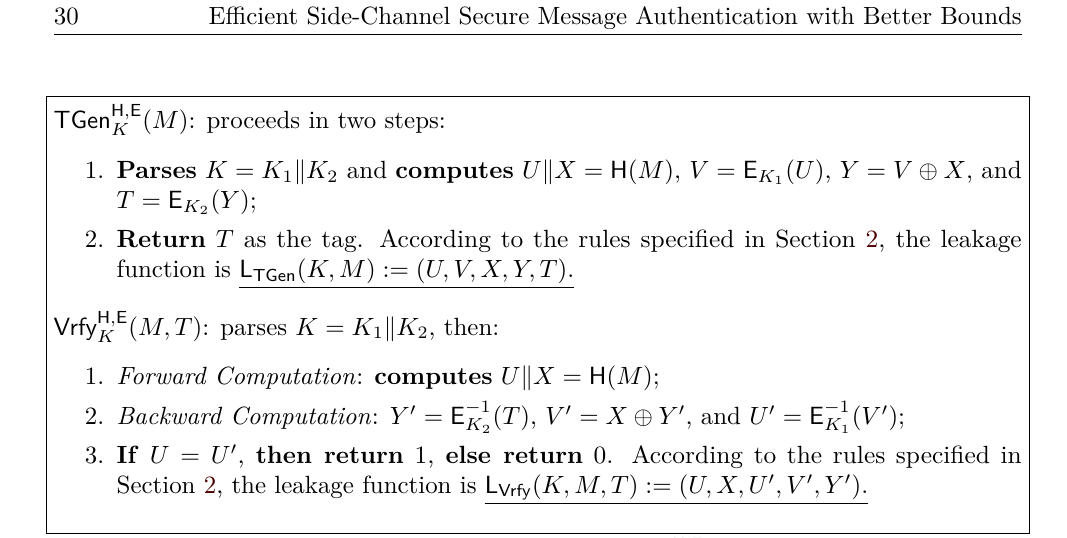
Figure 2: The description of LRWHM H , E MA